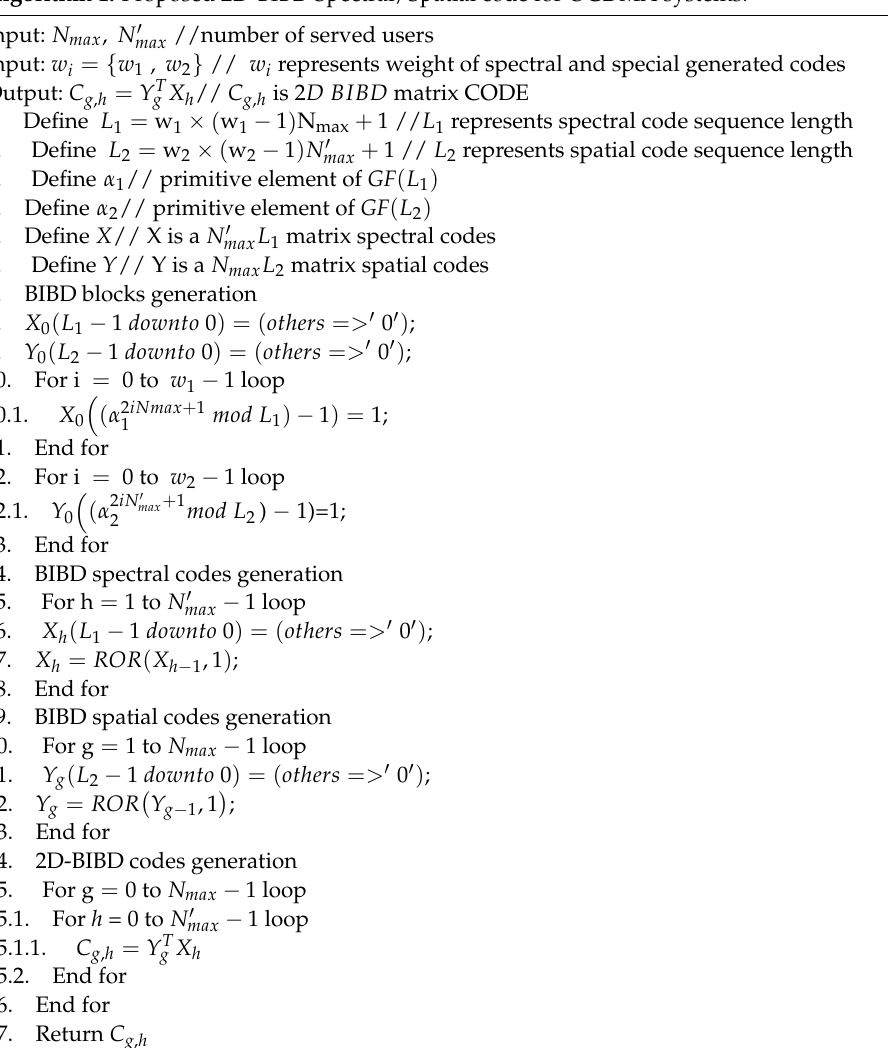
Algorithm 1. Proposed 2D-BIBD Spectral/Spatial code for OCDMA systems.